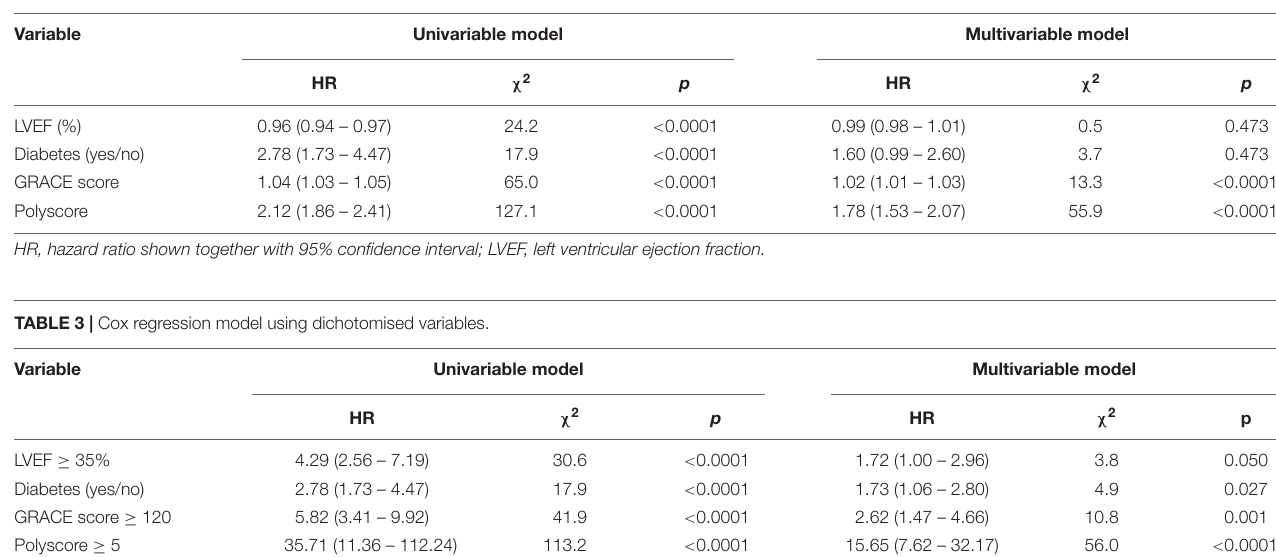
TABLE 2 | Cox regression model using non-dichotomised variables.